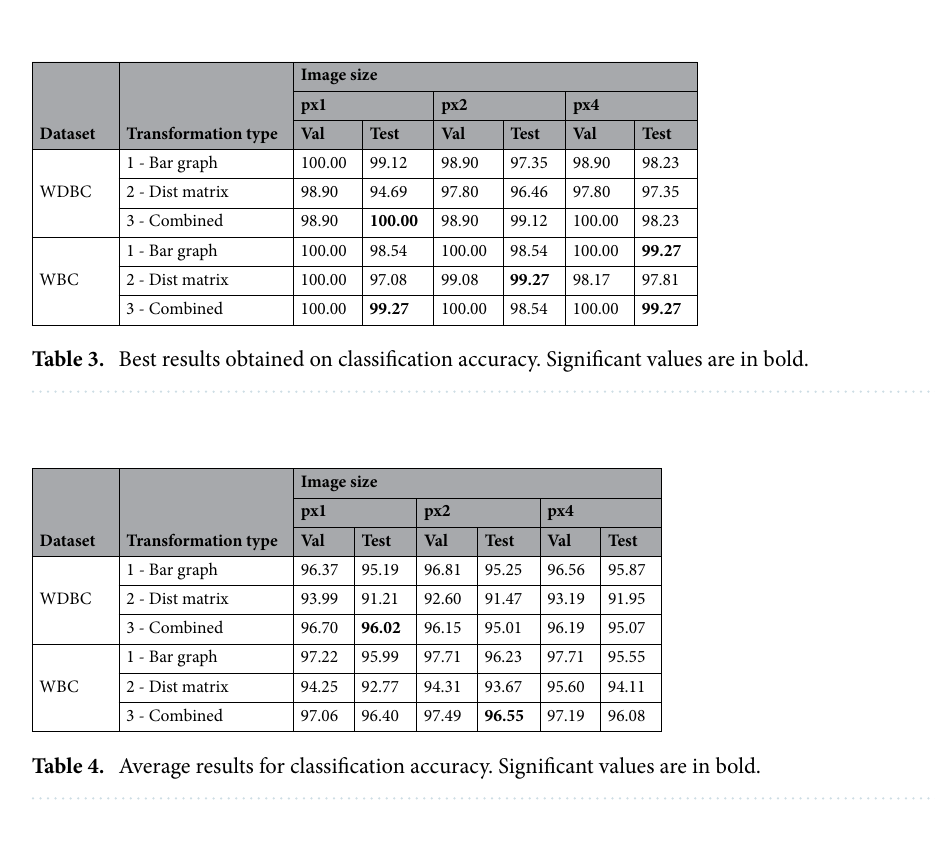
Table 2. Experimented dataset.